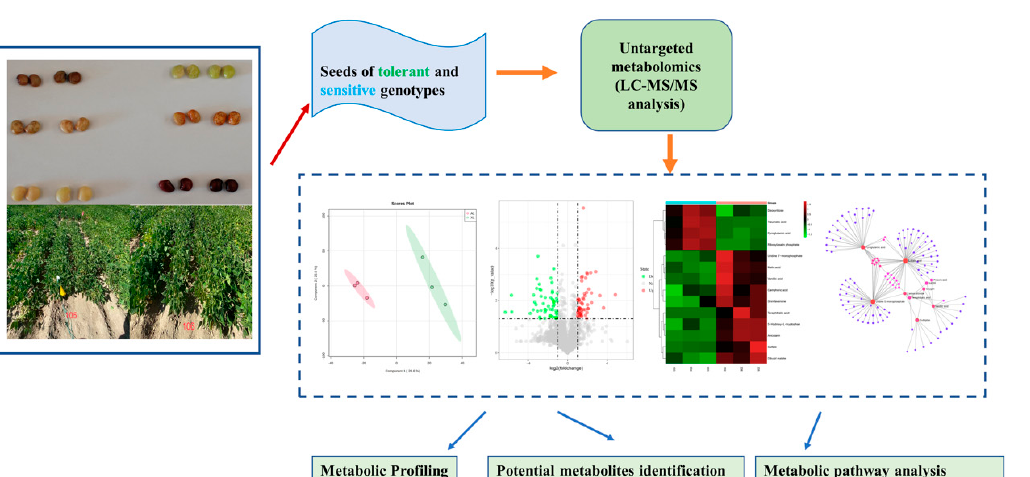
Figure 1. Overview of the untargeted metabolomic profiles of common bean seeds.